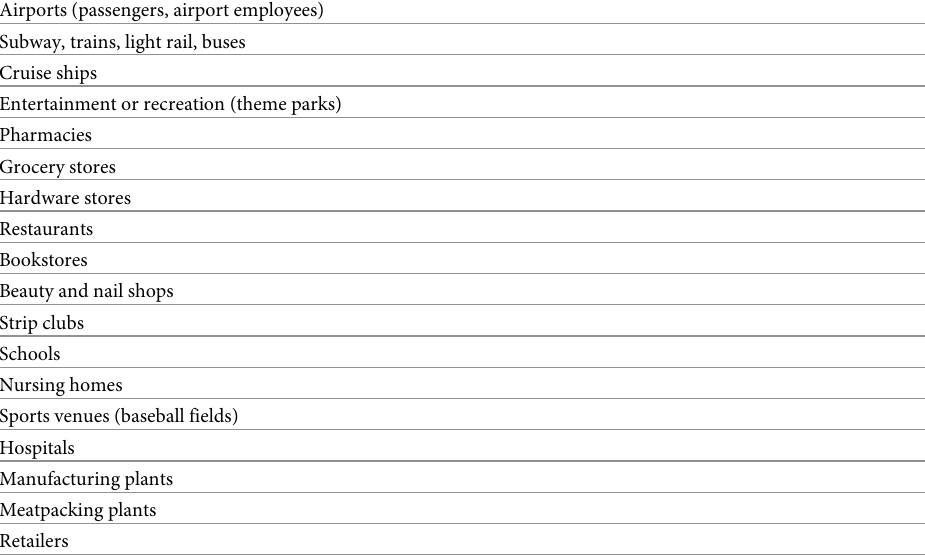
Table 2. Locations of mask-wearing observations signaling risk in public settings,